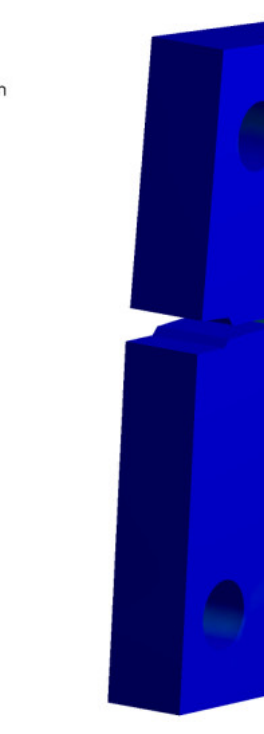
Figure 13. The equivalent von Mises stress distribution.